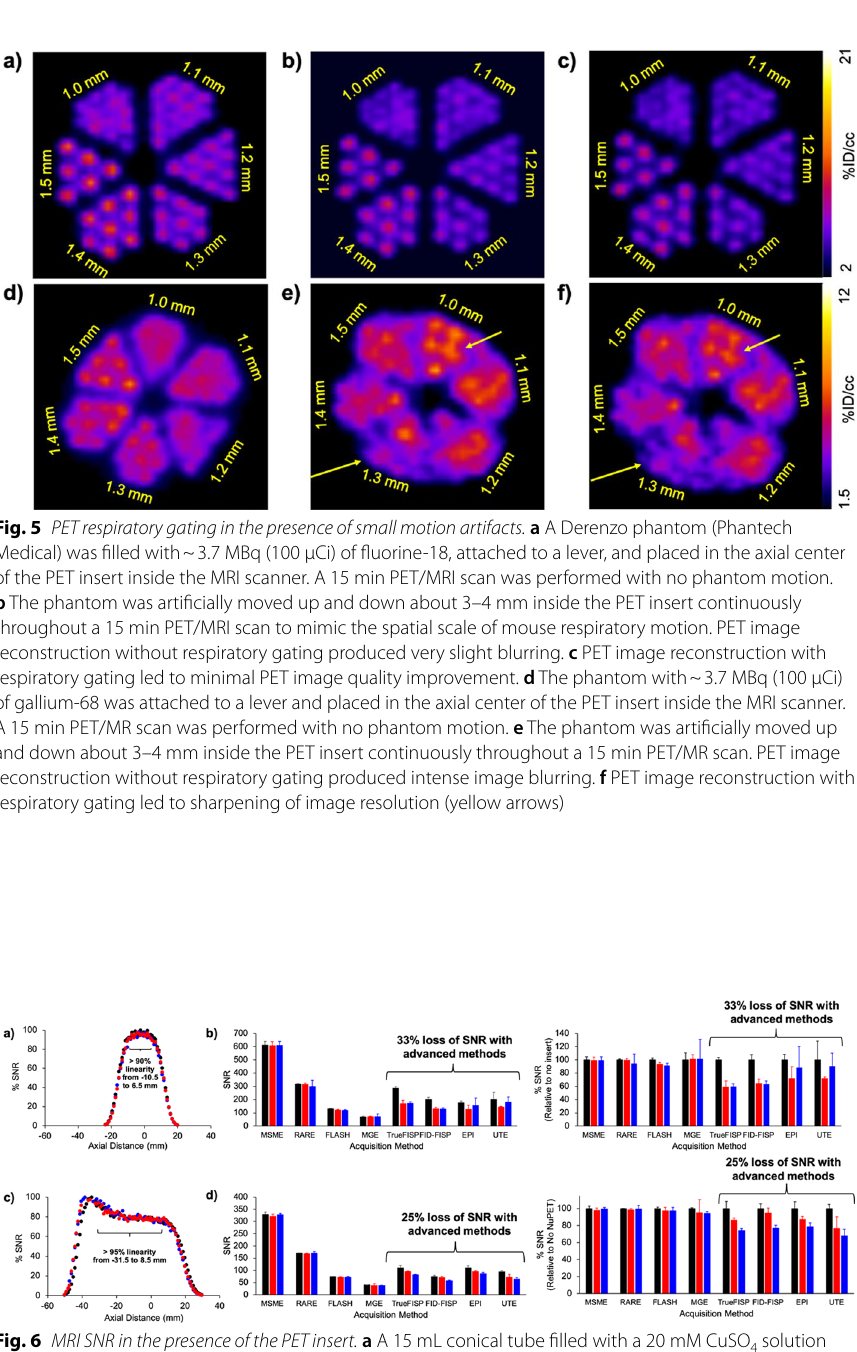
Fig. 6 MRI SNR in the presence of the PET insert. a A 15 mL conical tube filled with a 20 mM CuSO 4 solution was placed inside the MRI with the 35 mm Bruker MR coil and scanned with a MSME MRI acquisition without the PET insert (black), with the PET insert in the magnet and turned off (red), and with the PET insert in the magnet and turned on (blue). MR SNR and linearity were maintained throughout the axial FOV of the coil in all scenarios. b The PET insert did not affect SNR for MRI acquisition methods that are not gradient-intensive (MSME, RARE, FLASH, MGE). However, SNR decreased by 33% with gradient-intensive MRI acquisition methods (True-FISP, FID-FISP, EPI, uTE) when using the PET insert. c The same study was performed with the 35 mm PulseTeq MR coil. d The PET insert did not affect SNR for MRI acquisition methods that are not gradient-intensive (MSME, RARE, FLASH, MGE). However, SNR decreased by 25% with gradient-intensive MRI acquisition methods (True-FISP, FID-FISP, EPI, uTE) when using the PET insert. This loss of SNR was slightly more exaggerated with the insert turned on versus off when using the PulseTeq MR coil, but the opposite was true for the Bruker 35 mm MR